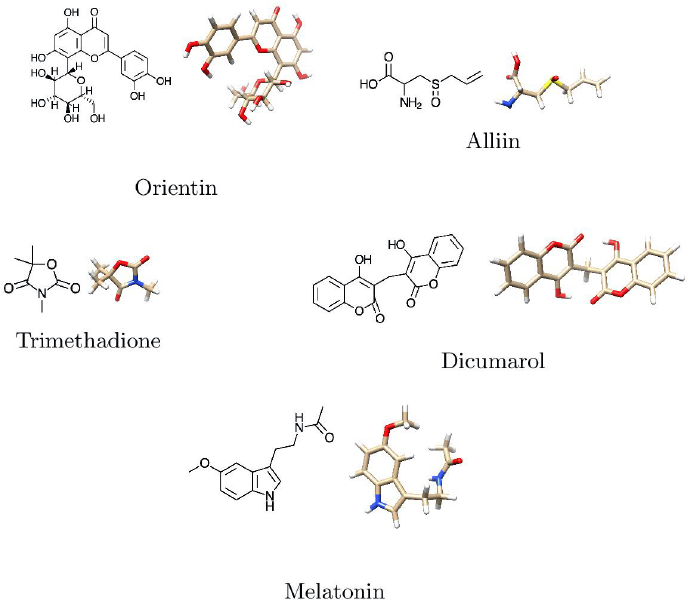
Figure 4. two-dimensional and three-dimensional structures of major phytobioactives.